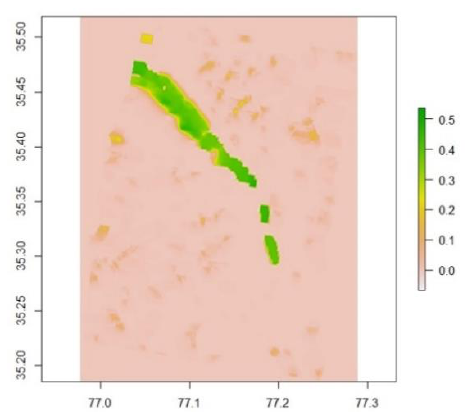
Figure 5: Siachen glacier velocity map using the descending pass TerraSAR-X images (03 Feb. 2014 and 18 Feb. 2017) (Figure scale in m day -1 ).